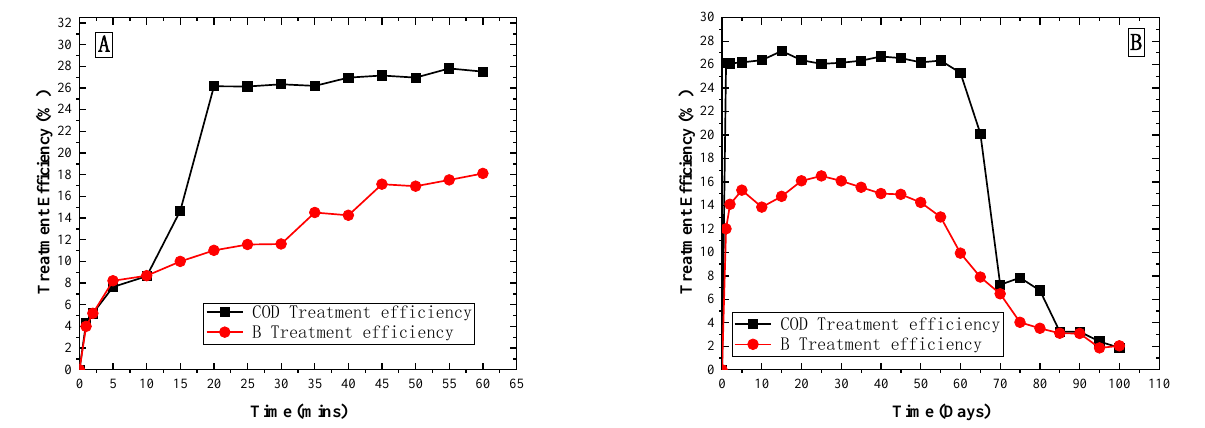
Figure 4. The adsorption efficiency and saturation test curves of activated carbon. ( A ) COD and Boron adsorption efficiency ( B ) COD and Boron treatment efficiency at 100 days.